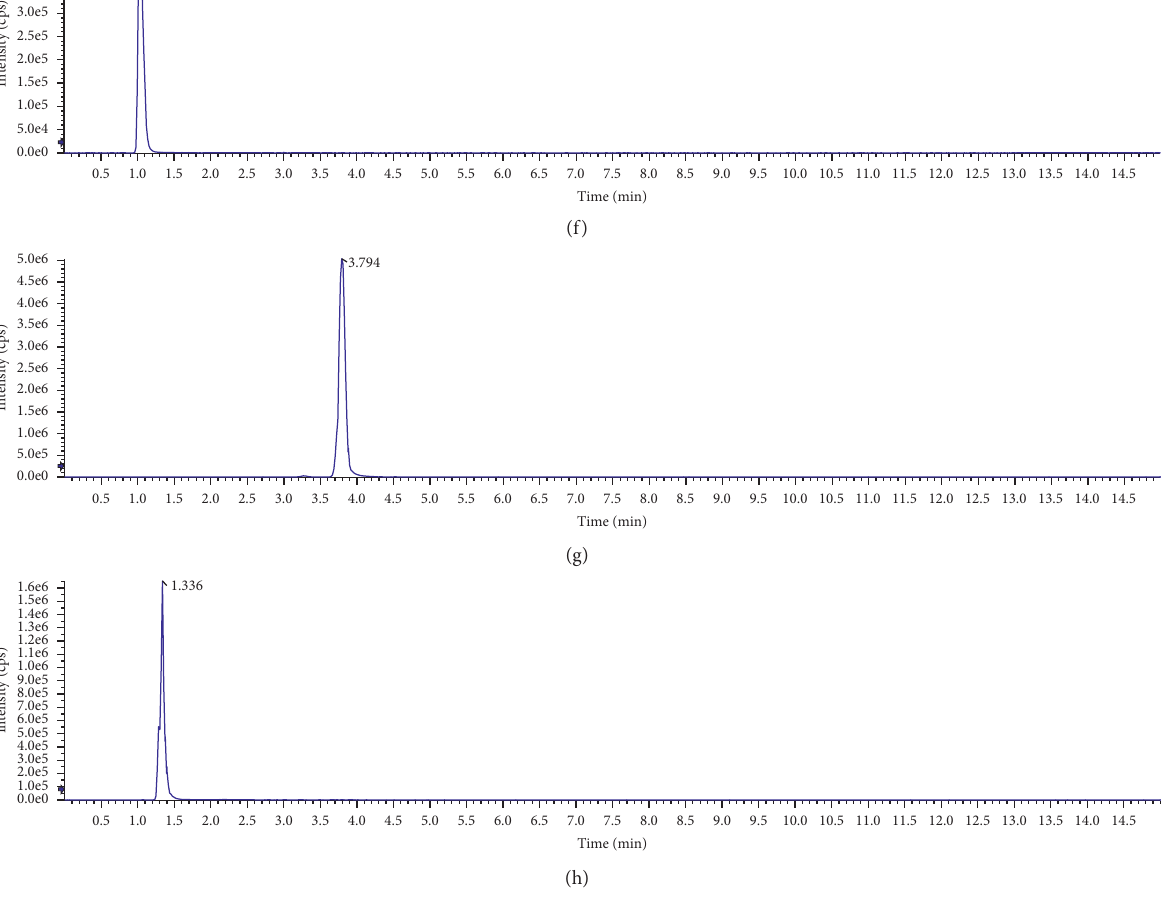
Figure 3: Extracted ion chromatograms of the 8 endogenous alkaloids. (a) Nicotine. (b) Anabasine. (c) Choline. (d) Tryptamine. (e) Putrescine. (f) Nicotinamide. (g) Muscarine. (h)